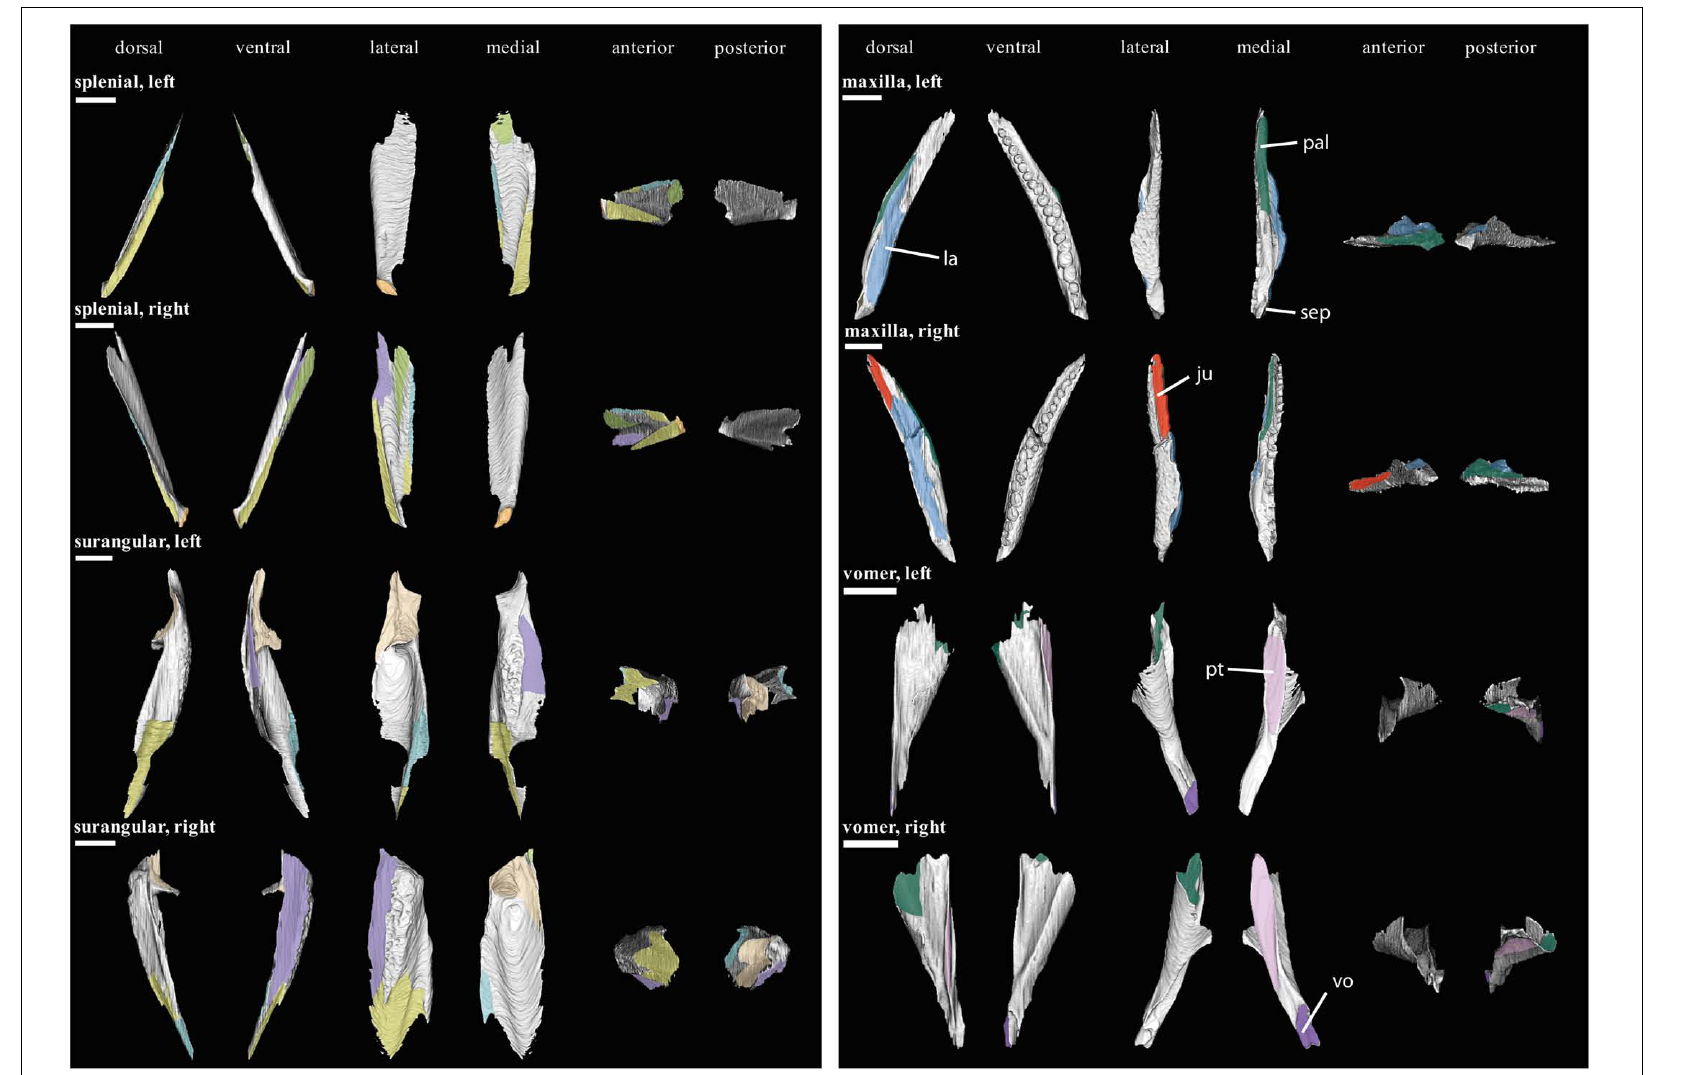
FIGURE 4 | Isolated bones in dorsal, ventral, lateral, medial, anterior and posterior views. Articulation areas with other bones are colored. Left and right splenial, left and right surangular, left and right maxilla, and left and right vomer are shown. Scale bar = 10 mm. For abbreviations see caption to Figure 1